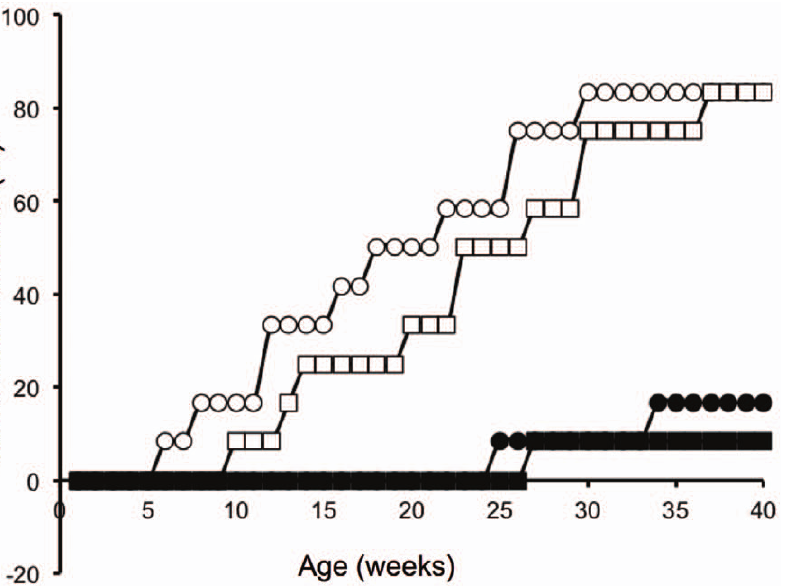
Figure 4. Cumulative incidence rate of diabetes development. NOD mice were injected with 50 and 100 m g MAb 8E6G4, presented as black circles and squares, respectively. Control animals were injected with PBS (white circles) or control mouse monoclonal antibody (white squares). Animals were weekly monitored for diabetes development. Cumulative incidence rate of diabetes development is presented as percentage.